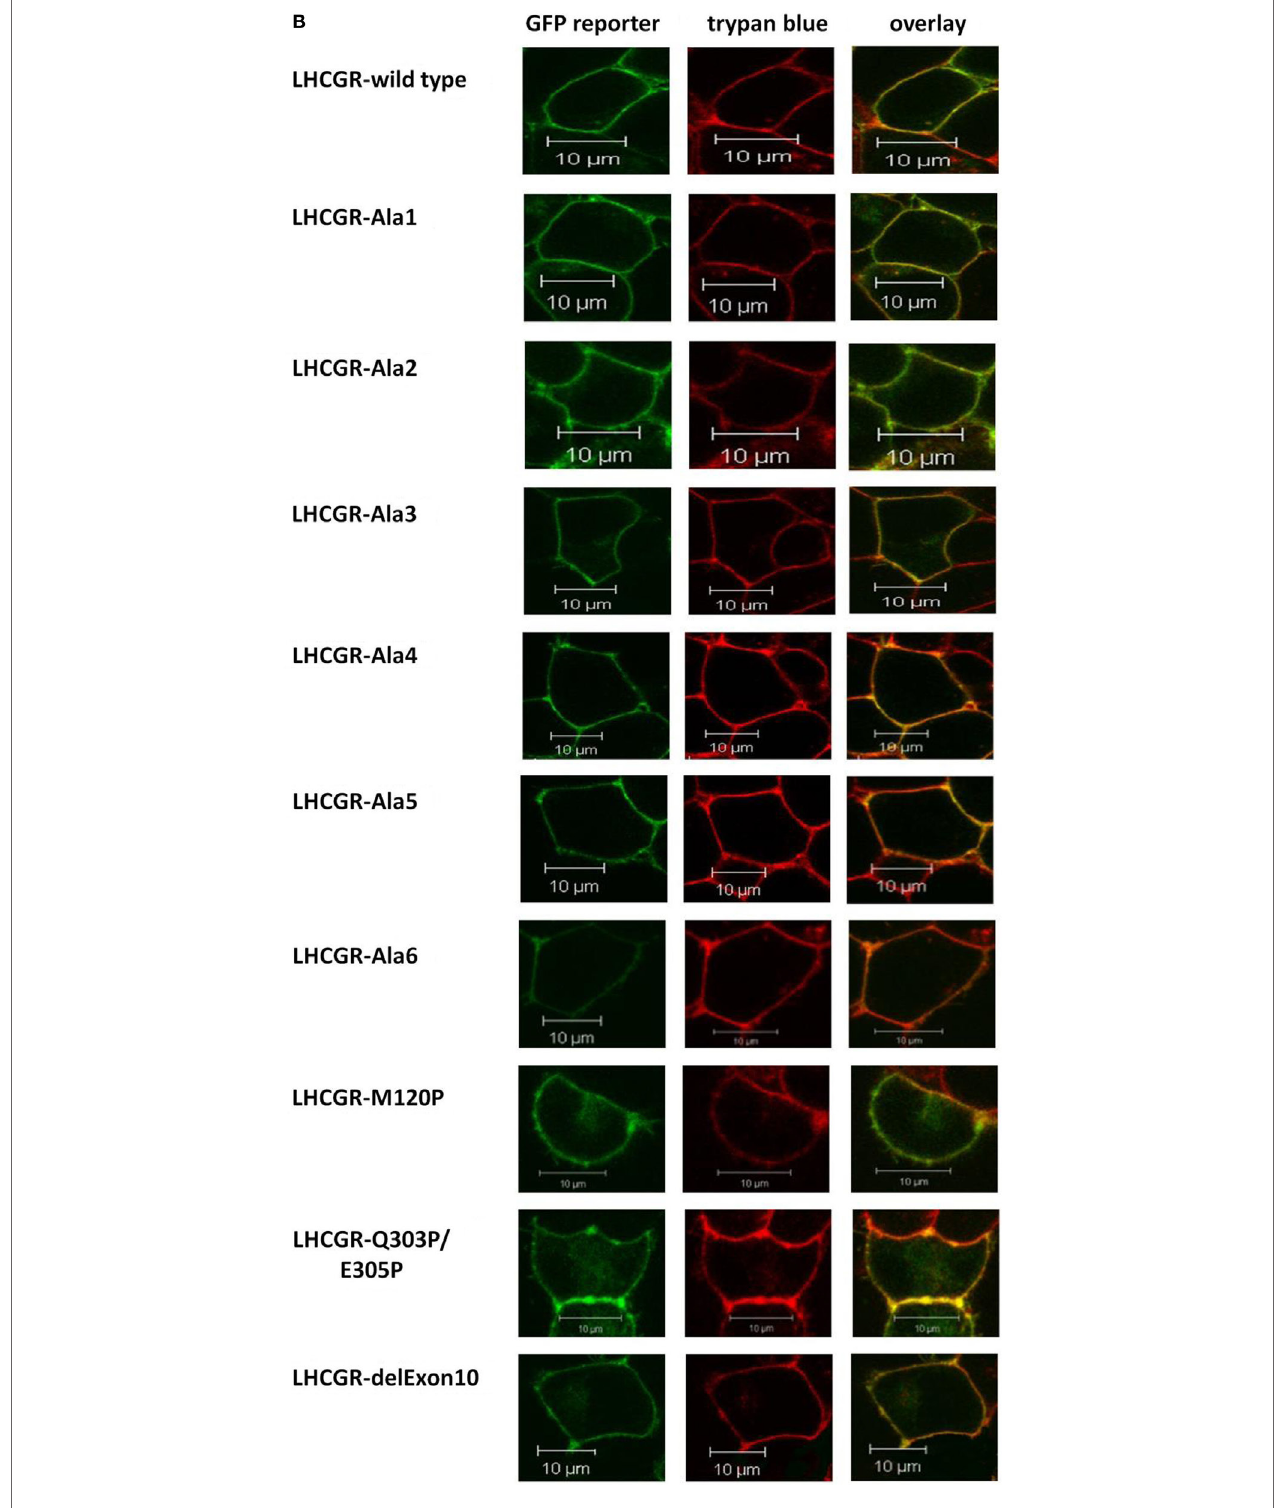
FigUre 5 | Mutations introduced in the middle of the lgcgr hinge region . (a) Sequence of LHCGR constructs of helix supporting block-wise polyalanine and directed helix-disturbing proline mutations within the exon10-helix and adjacent helix. (B) Localization of the GFP fluorescence signals of the LHCGR constructs in transiently transfected HEK 293 cells by confocal LSM. The GFP-signals of the fusions (left panel, green) and the Trypan blue signals of the membranes of the same cells (central panels, red) were computer-overlayed (right panels, yellow). GFP fluorescence is detectable only for transfected cells, whereas all cells show cell surface trypan blue fluorescence. All constructs are expressed on the plasma membrane